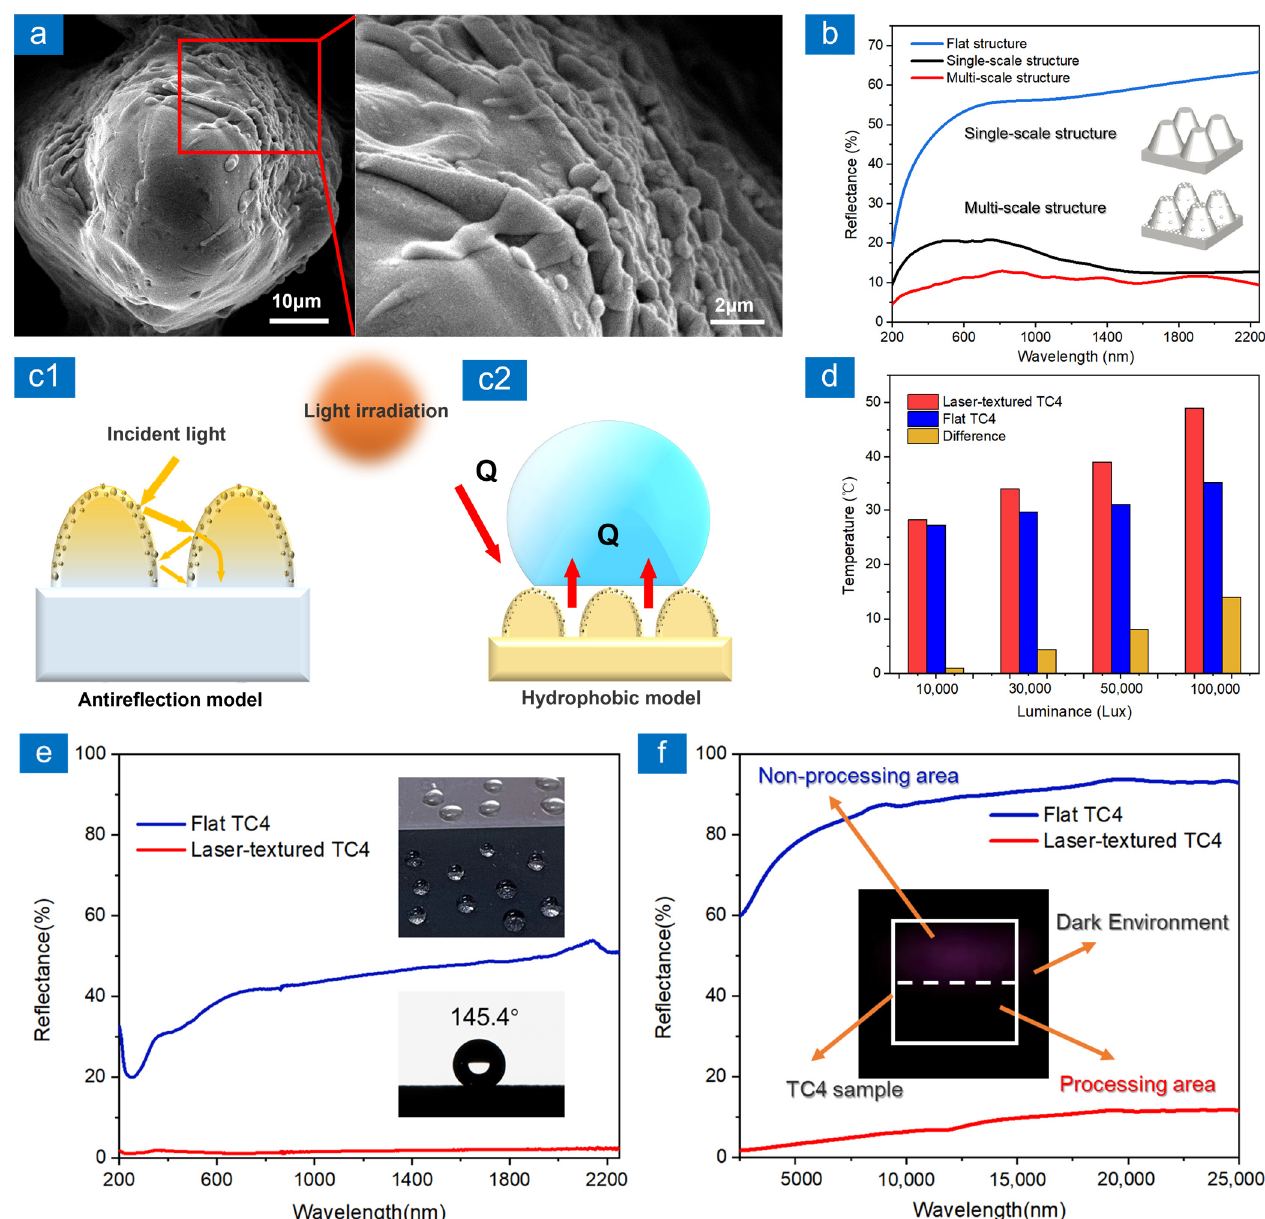
Figure 6. ( a ) Nanoparticles and nanotextures on multi-scale structured surfaces, ( b ) the reflectance simulations of single-scale and multi-scale structures by FDTD method, ( c ) the anti-reflection and wettability model of multi-scale structure, (d) the surface temperature increase of laser-textured TC4 and flat TC4 in the face of the same luminance, ( e , f ) the reflectance spectra of TC4 samples at different wavelengths, the static contact angle and the stealth effect of TC4 sample in dark environment. In addition, the laser-textured TC4 in Figure 6 is sample stru-120 (150 °C).